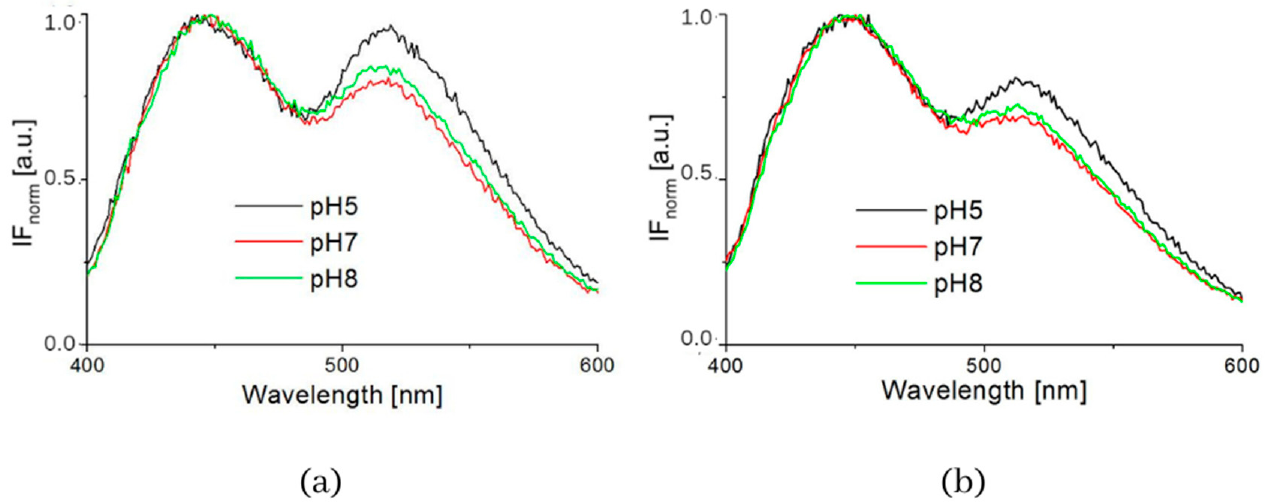
Figure 4. Intensity of fluorescence normalized spectra measured in buffers (pH = 5, 7 and 8) ( a ) 3T3 cells, ( b ) CT26 cells. Table 3. The ratios of areas under calculated Gauss curves of free and bound NADH, AF/AB, at pH